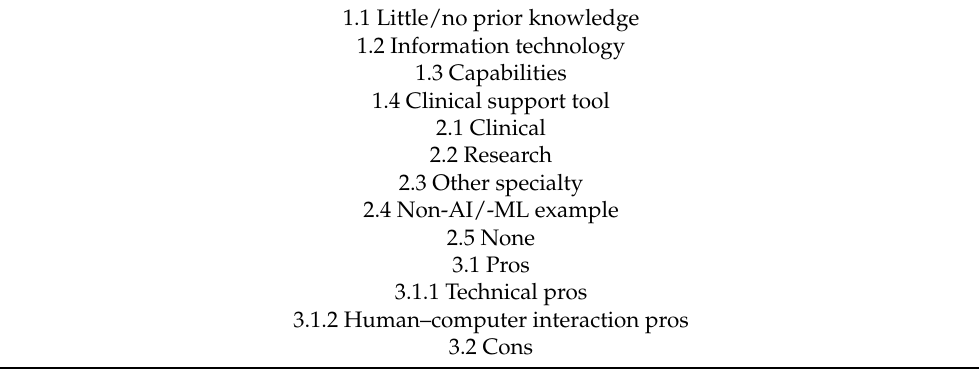
Table A1. Coding schemes derived from interview statements in part 1 of the